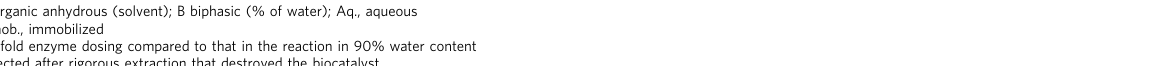
co-precipitated with lipases due to the electrostatic neutralization of surface charges (Fig. 3b). The entrapped Catlig-Lipase M precipitates were observed in the scanning electron microscopy (SEM) and confocal laser scanning microscopy (CLSM) images as free and nested clusters (Fig. 3g ‒ j). The third and most bene fi cial immobilization approach builds on the positive traits of the two